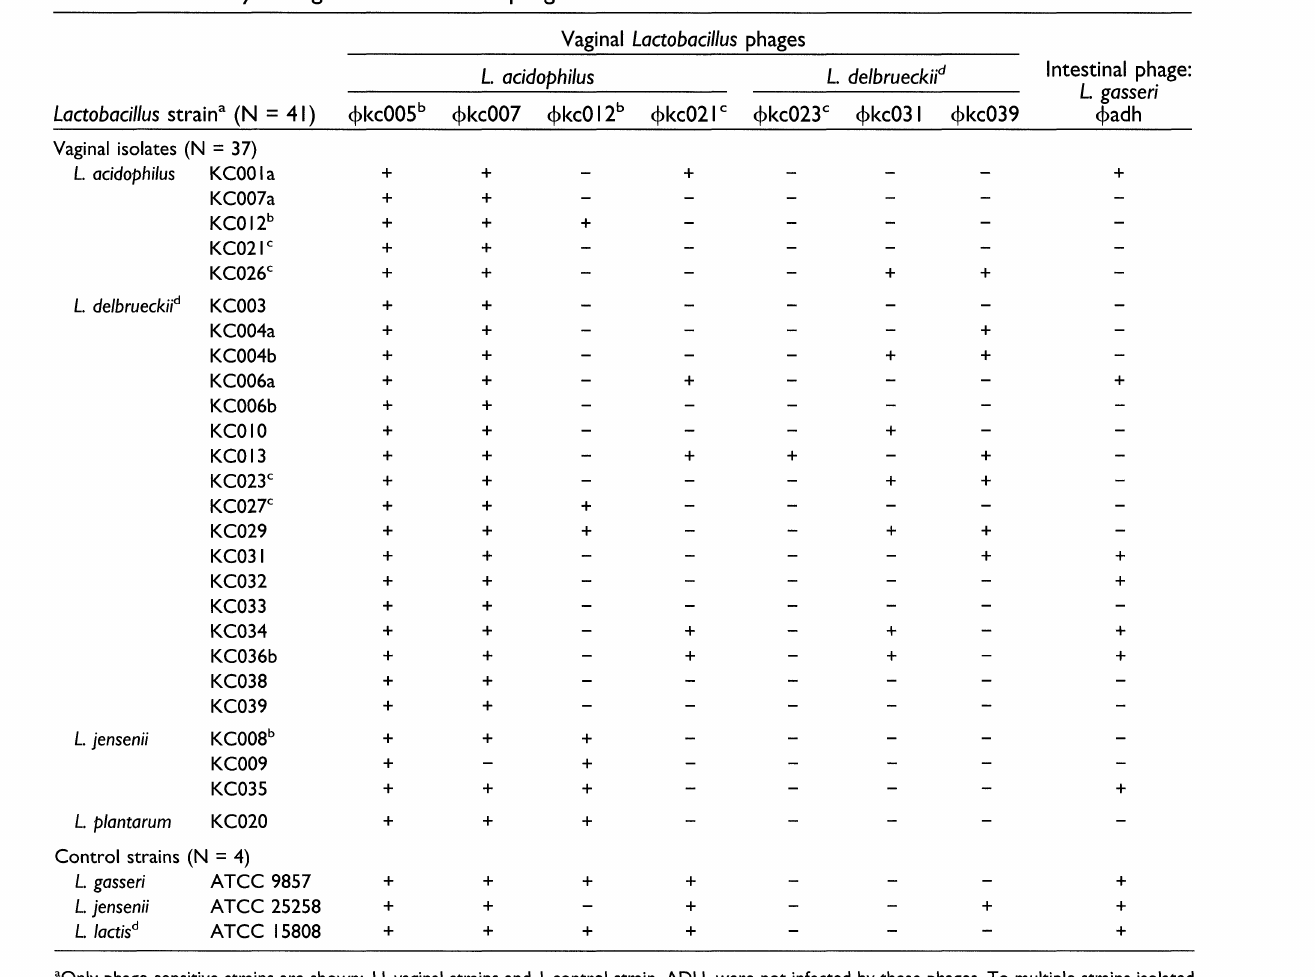
TABLE I. Sensitivity of vaginal lactobacilli to phages released from different lactobacilli